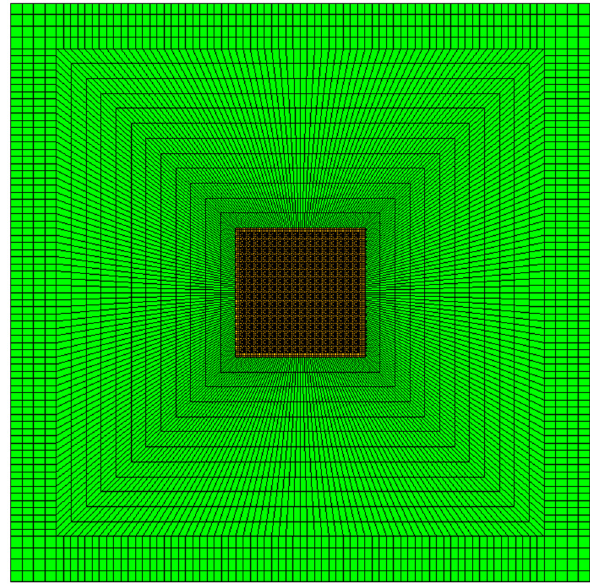
Table 2: Linear elastic material properties used in the FE